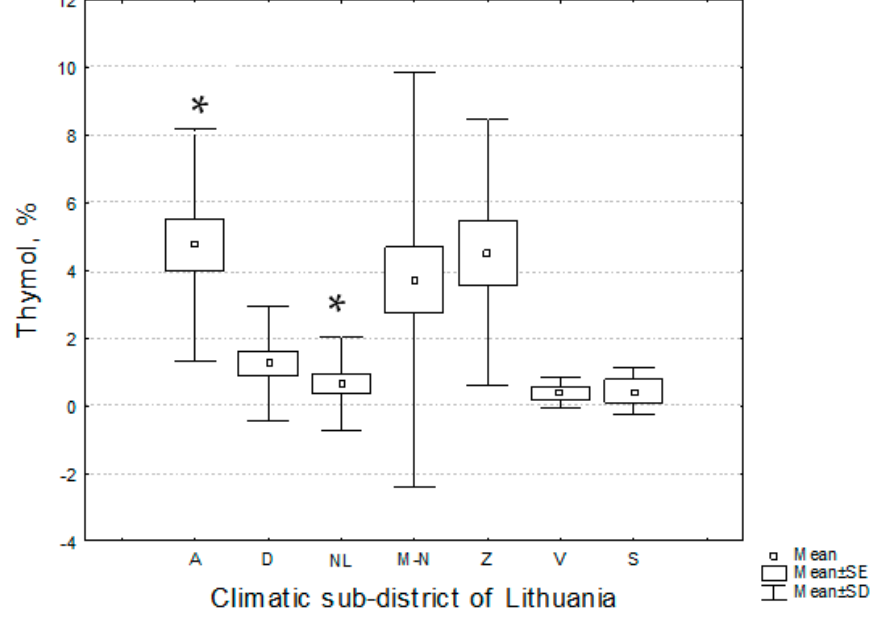
Figure 5. Distribution of the percentage of thymol in the essential oils of Thymus pulegioides habitats in different climatic sub-districts of Lithuania. Explication: A—Aukštaitija climatic sub-district, D—Dz ū kija, M-N—M ū ša Nev ė žis, NL—the Nemunas Lowland, S—S ū duva, V—Venta, Z—Žemai č iai. * denote statistically significant ( p < 0.05) differences.